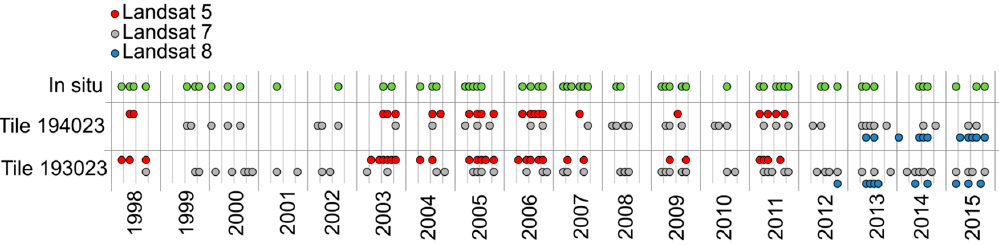
Figure 5. Time series of Landsat acquisitions (1998–2015), sorted by tile (cf. Figure 1) and sensor. “In situ” marks the date of in situ measurements at Feldberg Lake